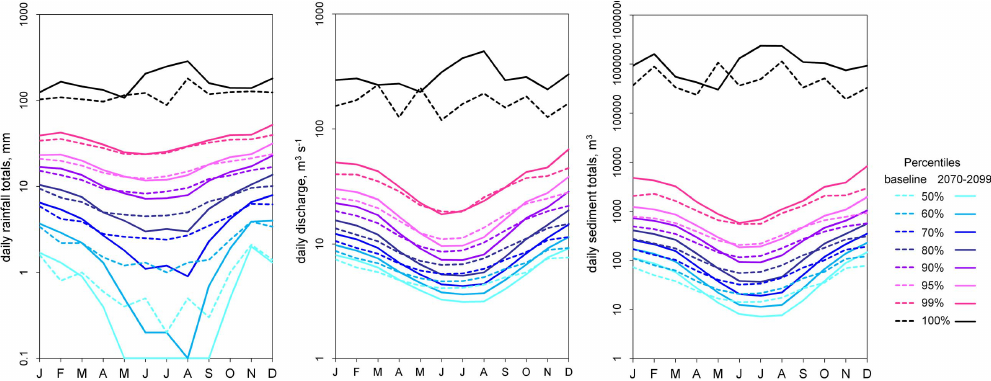
Fig. 7. Percentiles of daily rainfall, discharge and sediment totals per month for the baseline climate (1961–1990) and the High emissions scenario (2070–2099).